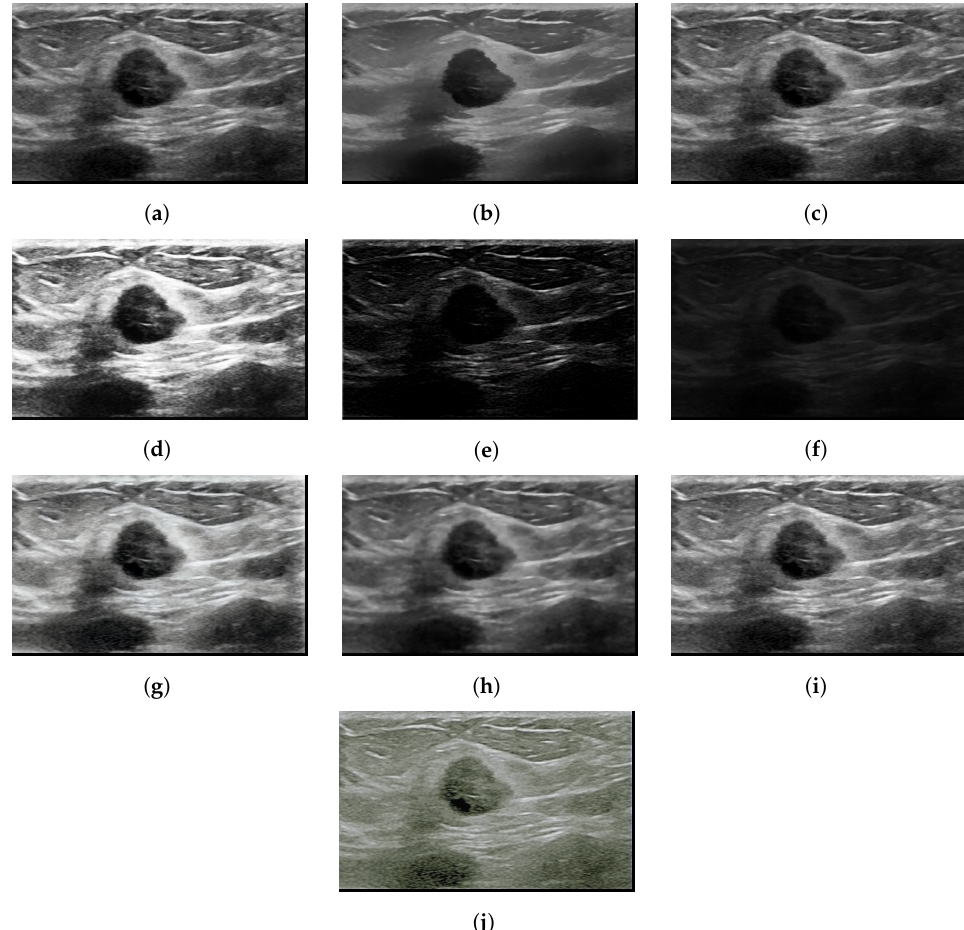
Figure 6. Malignant highlighted mammogram images ( a ) Original ( b ) Bilateral ( c ) Gamma correction ( d ) HE ( e ) LDNET ( f ) LIME ( g ) LLFLOW ( h ) TV ( i ) Ying ( j )